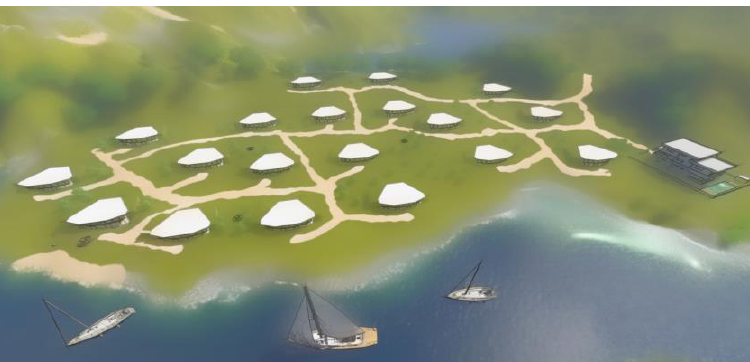
Figure 30. Perspective presentation of the tourist resort Lepenski Vir, which clearly shows the relationship of communications and facilities. Communication remained the same, and everything is just for pedestrians. There are trees and greenery on all sides. Lepenski Vir, Serbia (2019) by ArhiArhi (Predrag, Vladimir and Grigor Milošević)